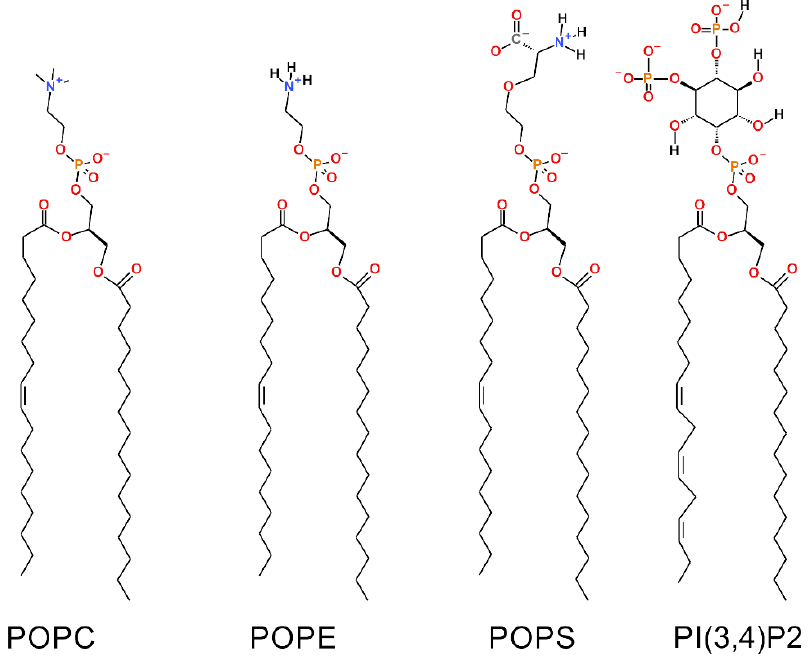
Figure 1. Chemical structures of the lipid molecules included in the outer mitochondrial membrane models. The 2D representations of: phosphatidylcholine (POPC), phosphatidylethanolamine (POPE), phosphatidylserine (POPS) and phosphatidylinositol (PI(3,4)P2).